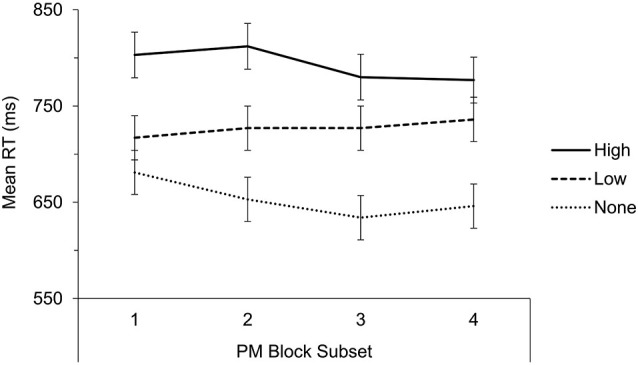
Mean correct RT in milliseconds (ms) for lexical decisions to filler words across conditions and subsets in the PM block. Error bars represent ± 1 standard error.